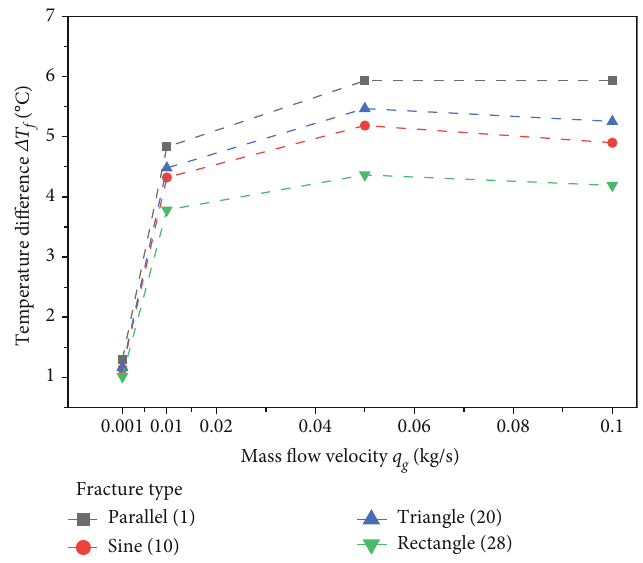
Figure 8: Average temperature di ff erence between fl uid and rock in fractures.